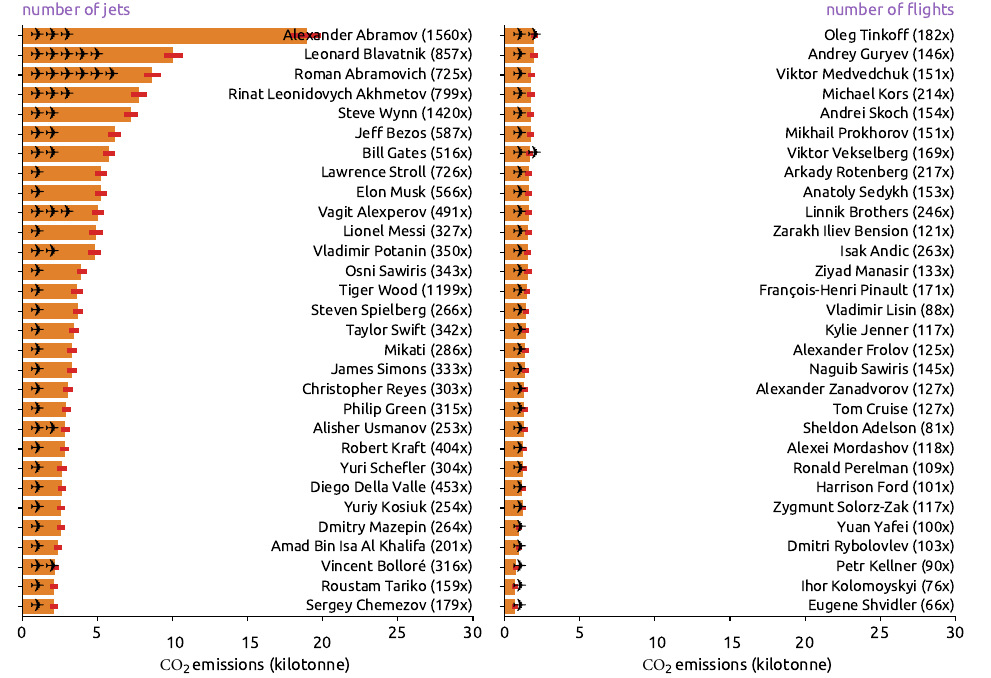
Figure 6. Flight CO 2 emissions associated with private jet owners.